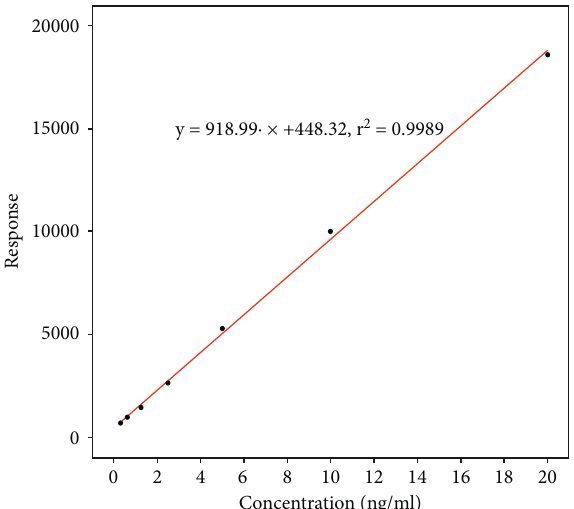
Figure 4: Calibration data of hydromorphone and hydromorphone-D3 used as the internal standard for the range of 0.3 to 20ng/mL. The black circles represent the calibration samples, and the red line represents the calibration curve determined by linear regression. The response was calculated from the area under the curve of the hydromorphone peak (AUC HM ), the area under the curve of the internal standard peak (AUC IS ), and the concentration of the internal standard (C IS ): response � AUC HM /AUC IS ∗ C IS